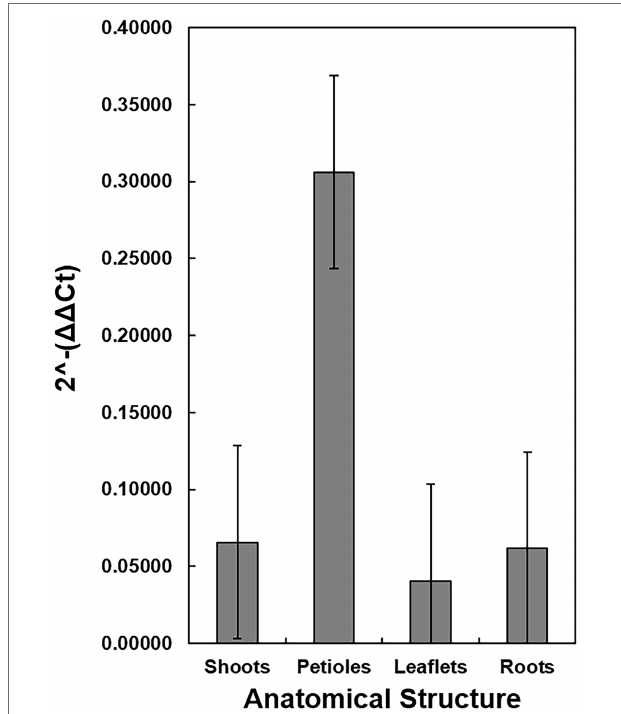
FIGURE 6 | Detection and Quantification of X. fastidiosa DNA in different anatomical structures of c.v. Cape Fear seedlings. Eight seedlings (cultivar Cape Fear) were harvested and the four anatomical structures (petioles, apical shoot, tap root, and leaflets) were dissected using a scalpel. The 2 - ΔΔ Ct of X. fastidiosa DNA amplification normalized to pecan DNA amplification of each sample was estimated by qPCR. Error bars indicate standard errors of the mean values.